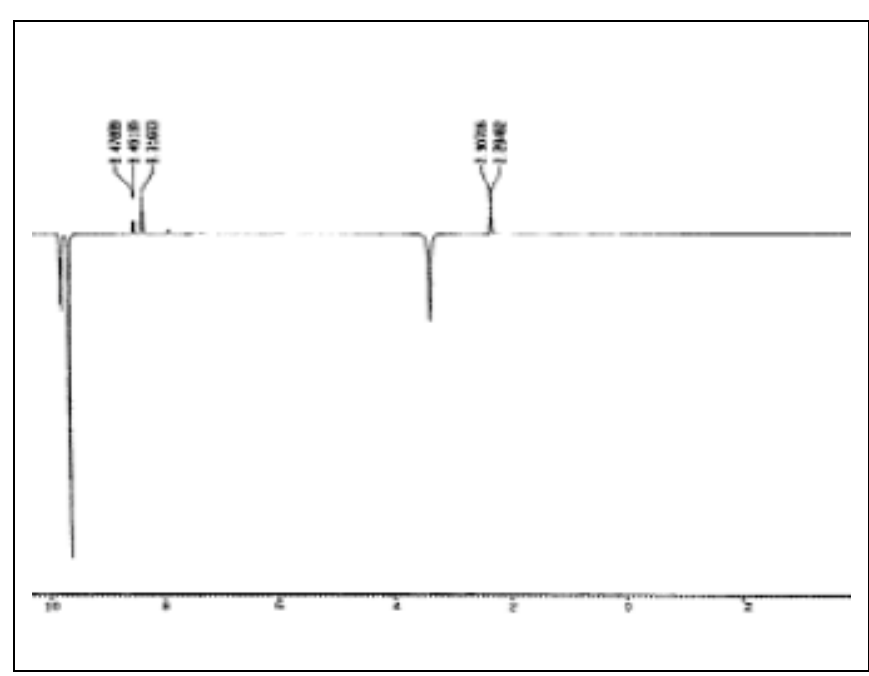
Figure 4. NOE Experiment on 5